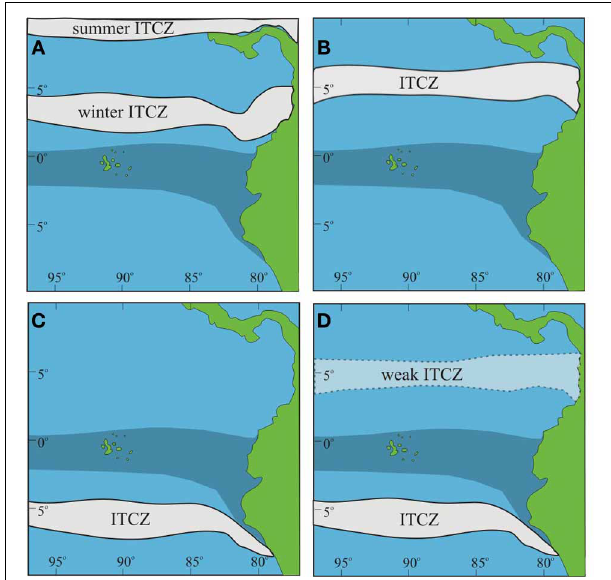
FIGURE 9 | Scenarios for ITCZ formation during the LGM. Upwelling off South American coast is shaded. (A) Modern ITCZ location; (B) ITCZ constrained to northern hemisphere; (C) ITCZ constrained to southern hemisphere; (D) ITCZ in southern hemisphere with weak ITCZ manifested in northern hemisphere.